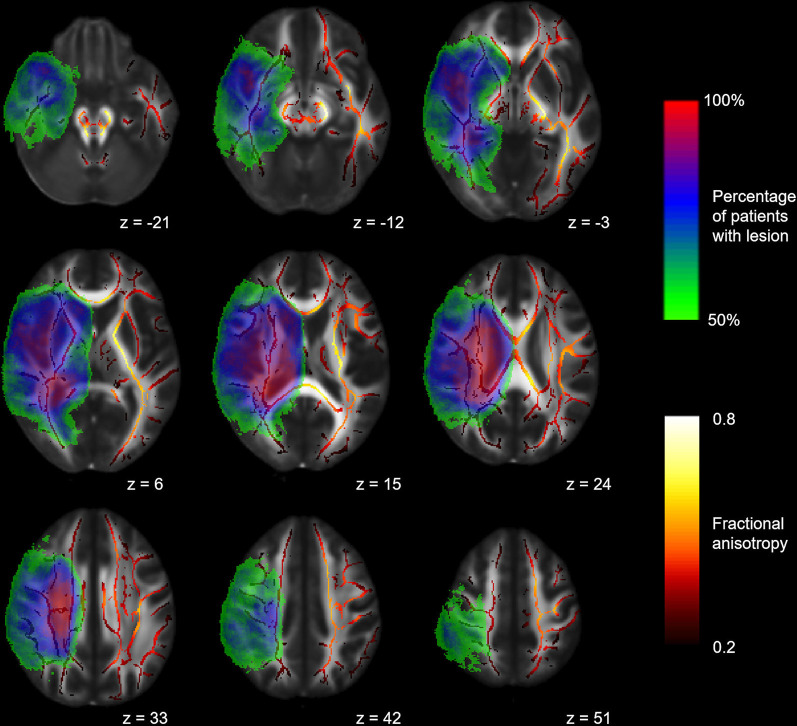
Mean fractional anisotropy (FA) skeleton and canonical lesion mask. Mean FA skeleton (red to yellow) of all subjects and canonical lesion mask (rainbow) created from all patients shown on the FMRIB58_FA template. Volumes of patients with left-hemispheric lesions are flipped along the x-axis. Coordinates are provided in MNI standard space.